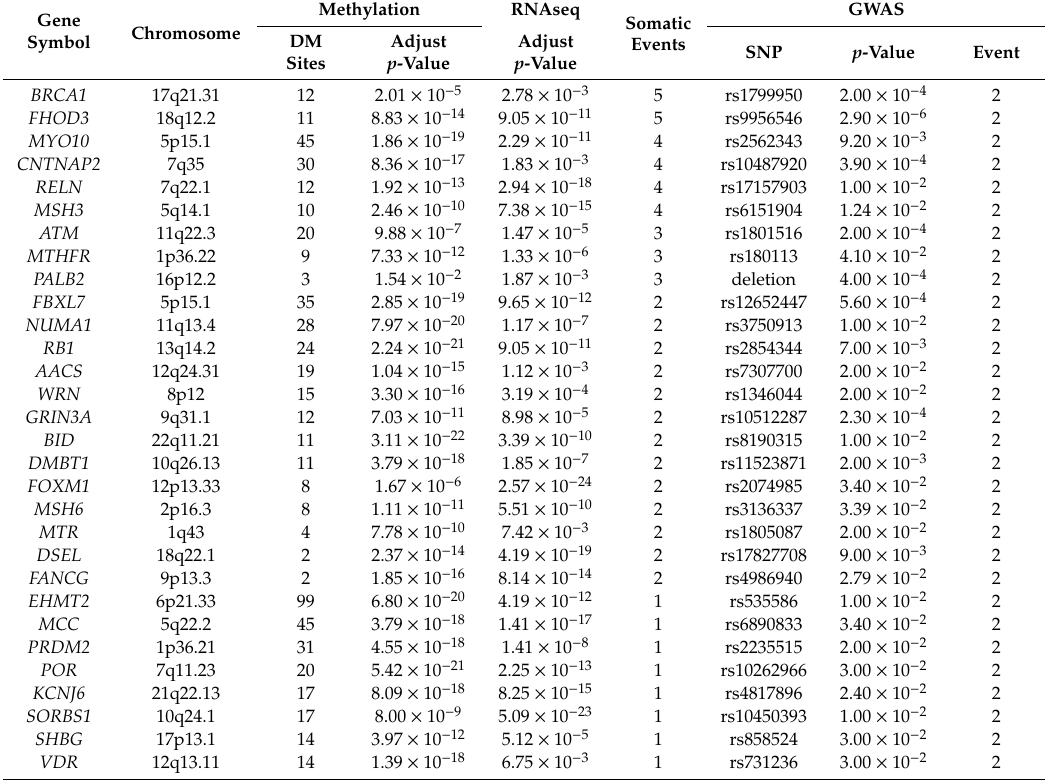
Table 4. Top list of genes in the d iscovered signature of genes containing somatic, germline and epigenetic vaariation. DM represents di ff erentially